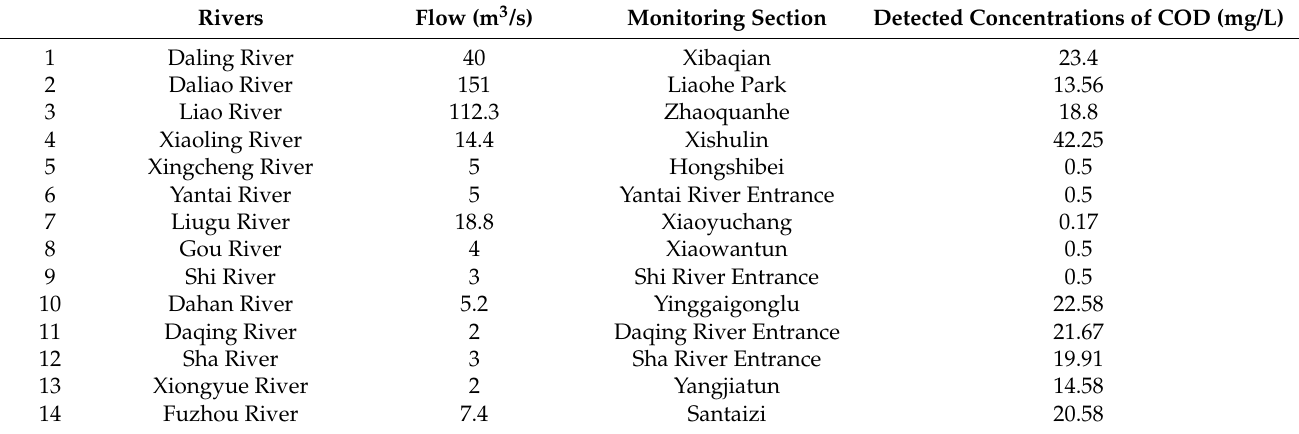
Table 1. Data of 14 rivers that enter Liaodong